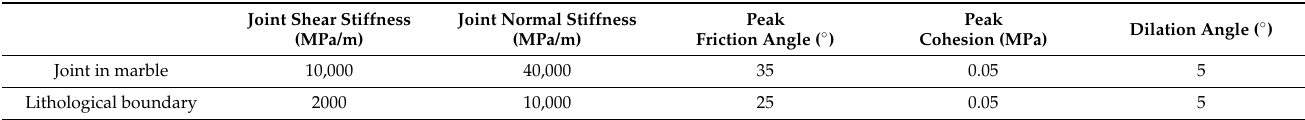
Table 3. Engineering–geological properties of discontinuities.